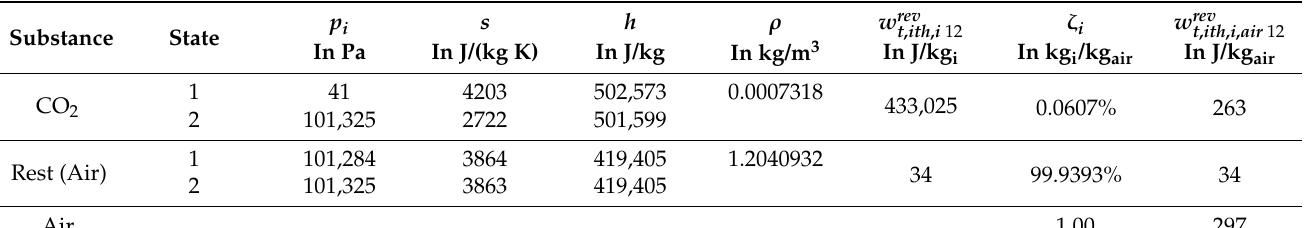
Table 2. Property values and results of the reversible isothermal partial compression for CO 2 removal at 293.15 K (Database: